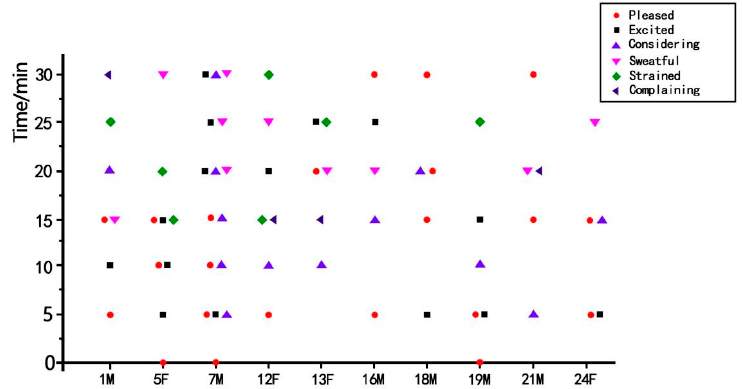
Figure 7. Whole-process feeling distribution of 10 participants.